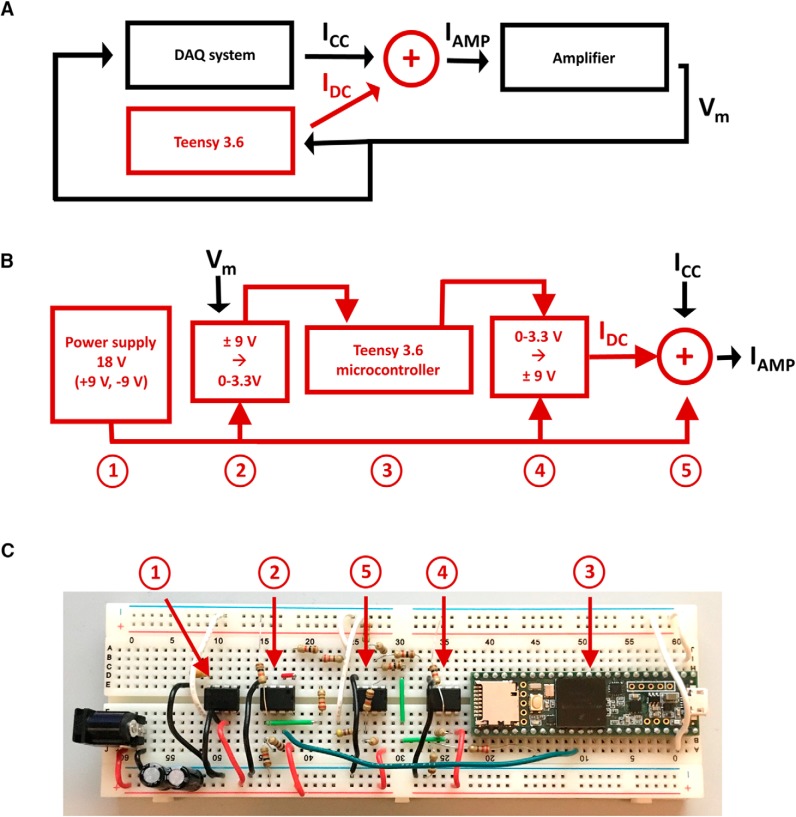
Schematic representations of the system. A, The Teensy 3.6 microcontroller and its associated electronics (red) are added to an existing system (black) consisting of an intracellular amplifier and a data acquisition (DAQ) system. The amplifier sends the membrane potential Vm to both the DAQ system and the Teensy system. The DAQ system, which could (for example) be comprised of a Digidata 1500 and pClamp 10 software, records Vm to disk as usual and specifies whatever current (ICC) it would inject in a standard current-clamp configuration. The microcontroller uses Vm to calculate what current (IDC) the dynamic clamp conductances would have passed had they been physically present. The sum of these two currents, IAMP = ICC + IDC, is sent to the command input of the amplifier to be injected into the neuron. B, The Teensy system consists of five parts: (1) a power supply 18 V, which is broken up into a positive voltage (9 V) and a negative voltage (–9 V) to power the other circuits and to provide both positive and negative rails; (2) a differential amplifier circuit that maps the output of the intracellular amplifier, which will be in the range ±9 V, onto the range 0–3.3 V that the Teensy can read; (3) the Teensy controller itself; (4) a second differential amplifier circuit that maps the output of the Teensy, which will be in the range 0–3.3 V, onto the range ±9 V the intracellular amplifier expects at its command input; and (5) a summing circuit that adds the voltage commands representing ICC and IDC. A voltage representing the sum IAMP is sent to the intracellular amplifier and thereafter injected into the neuron. C, The entire system can be built on a standard solderless breadboard. The five parts of the system are indicated by the arrows. All of the components (resistors, capacitors, ICs, wires, and microcontroller) can be secured simply by pushing their wires into the breadboard holes; no soldering is required. A detailed, step-by-step description of how to assemble the five parts of the system on a breadboard is available in the Extended Data 1 (“Assembling the system on a solderless breadboard”).